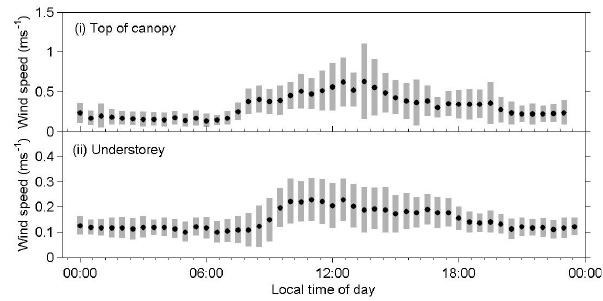
Fig. 3. Diurnal mean wind speed (i) at the top of the canopy and (ii) in the understorey, June–July 2008. Circles represent mean wind speed and boxes represent ± 1standard